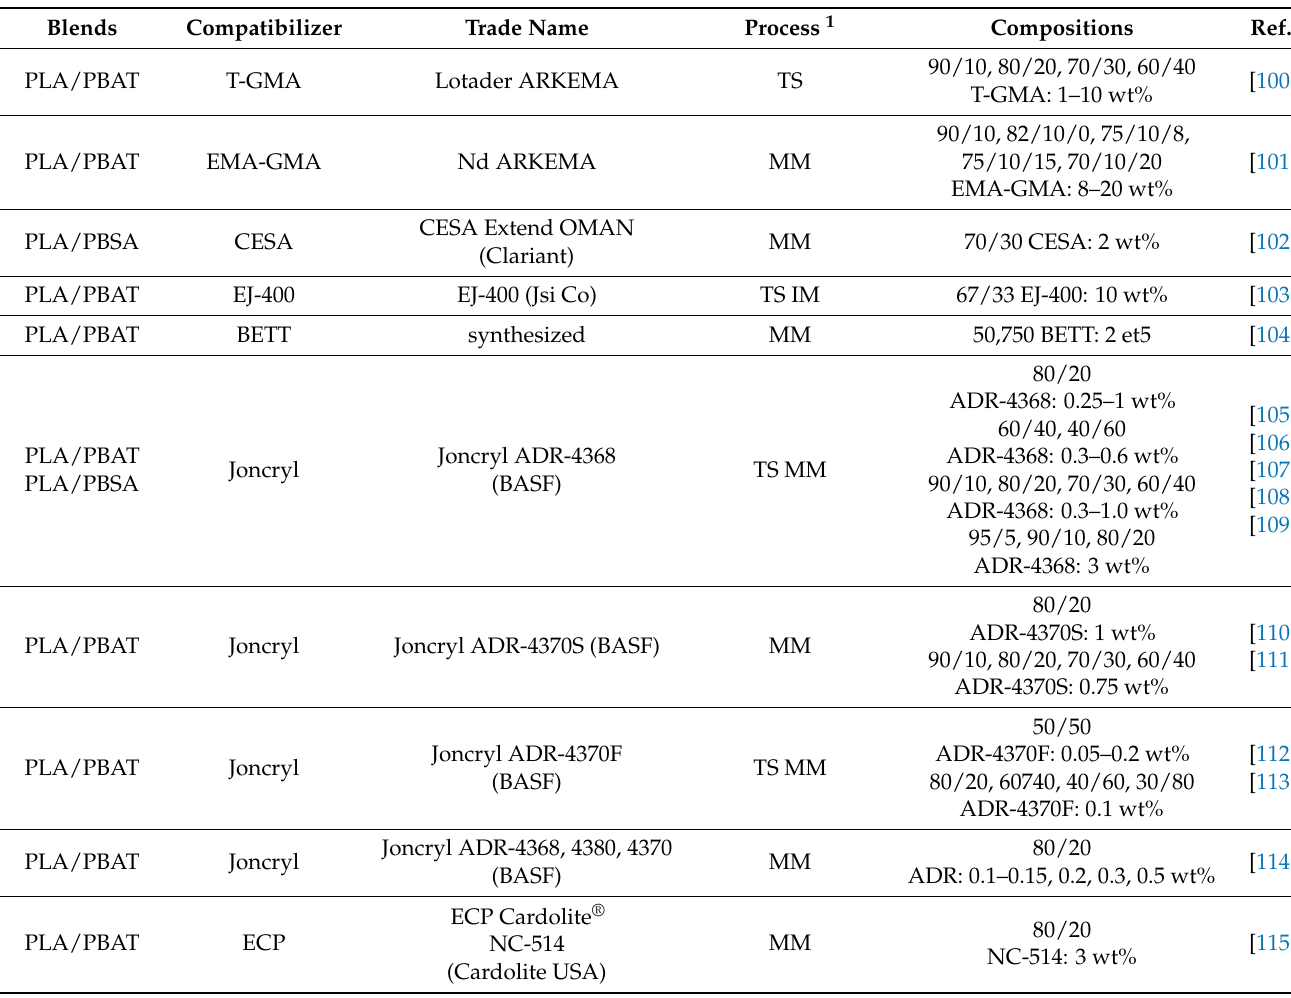
Table 2. Mostly used precursors of compatibilizers containing epoxy functionalities, blends compositions and type of